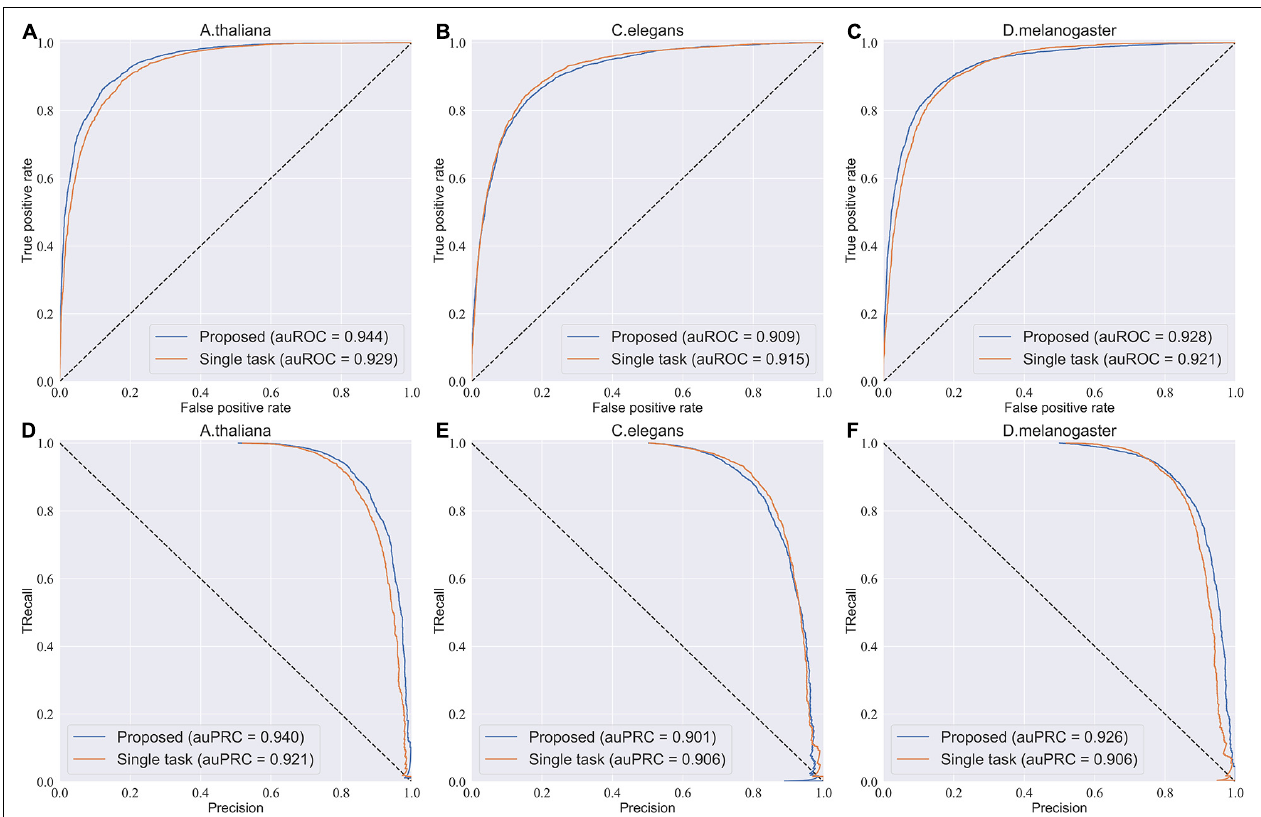
FIGURE 2 | ROC curves and PR curves of the model using multi-task learning and the model not using multi-task. (A–C) The ROC curves of the two models in three species. (D–F) The PR curves of the two models in three species.